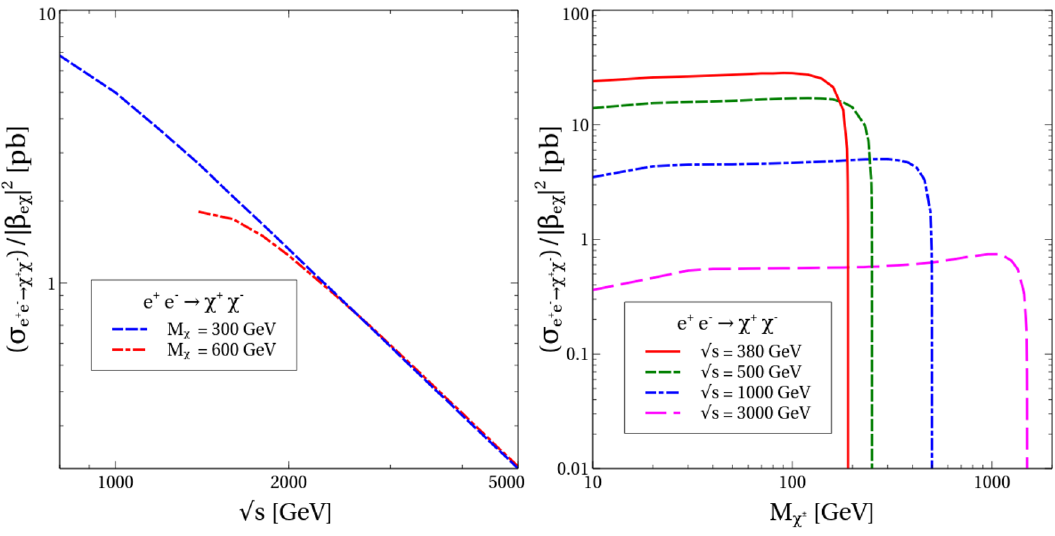
Figure 12 . Left panel shows the pair production of χ + and χ − for different c.o.m energy for two values of χ ± mass at the e + e − lepton collider. Right panel shows the variation of χ + and χ − production rate with χ ± mass M for different values of c.o.m χ ±